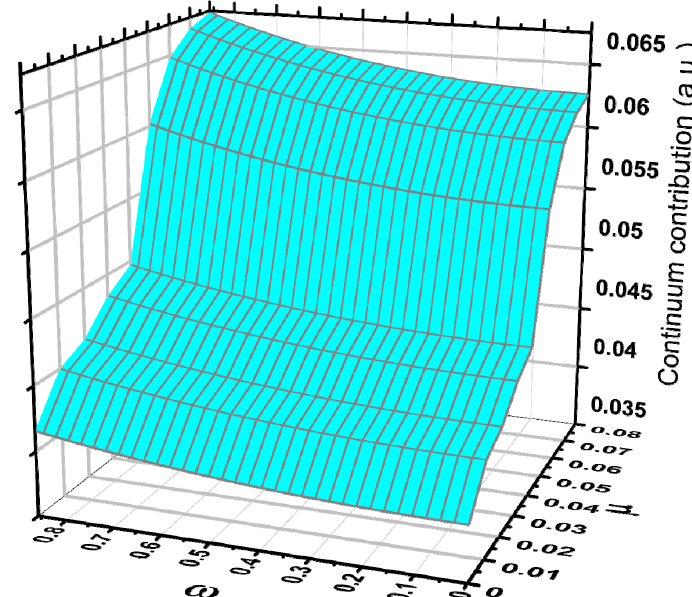
Figure 4. The contribution from the continuum states to dynamic quadrupole polarizability (DQP) as a function of the screening parameter and photon frequency.